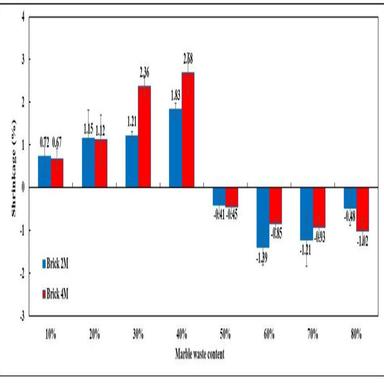
Dimensional stability of hybrid geopolymeric composite samples prepared at different molarities and marble waste content.